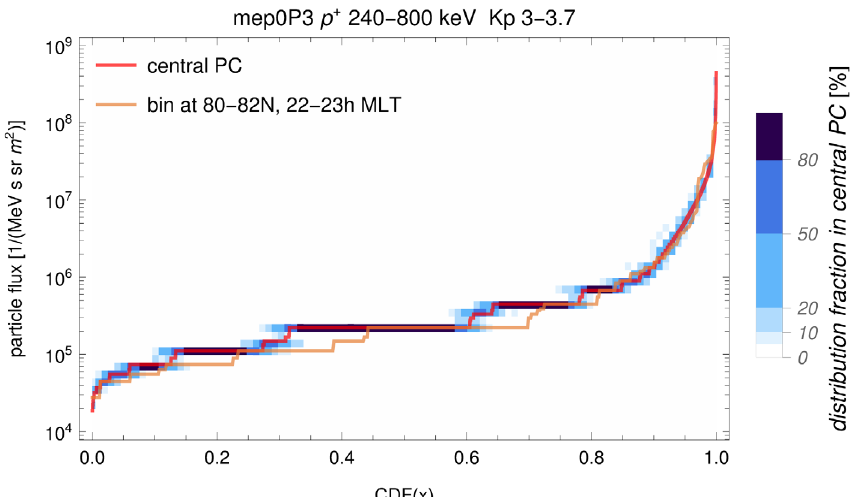
Figure 4. The fi gure shows the comparison of the central polar cap fl ux distribution ( (cid:5) 86 (cid:1) north and south) and a single bin. The difference is indicated by the D -test. The blue-shaded area counts the fraction of single bin cumulative distribution functions (CDFs) inside the central polar cap as indication of the low statistical